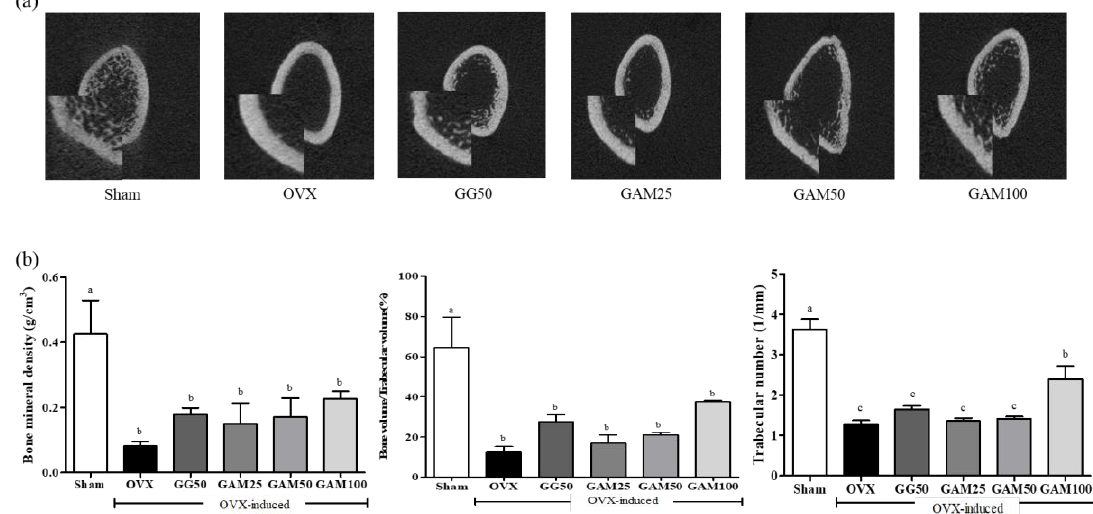
Figure 4. Effects of GAM on bone density in OVX-induced rat models. The effects of GAM on bone density were evaluated using micro-computed tomography analyses: ( a ) transverse μ-CT images of the experimental groups, and ( b ) bone mineral density, percent bone volume ration, and trabecular bone number measurements from a 3D image analyzer. a–c Mean values with different letters differed significantly ( p < 0.05) among groups, as shown by Tukey’s test.